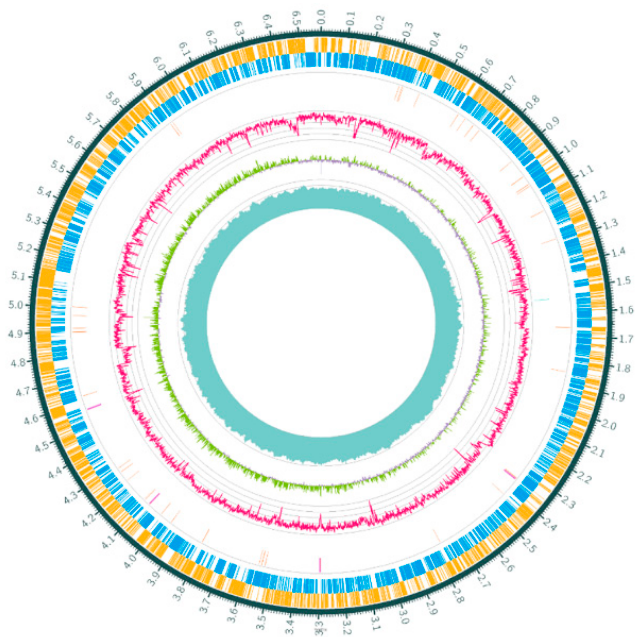
Figure 1. Graphical circular schematic map of the clinical isolate Pa150 from circle 1 (outmost) to circle 7 (innermost). Circles 1 and 2, coding sequences (CDS), forward and reverse frames, respectively; circle 3, tRNAs (orange) and rRNAs (purple); circle 4, CRISPR-related genes (blue); circle 5, GC content; circle 6, GC-Skew; circle 7, coverage.